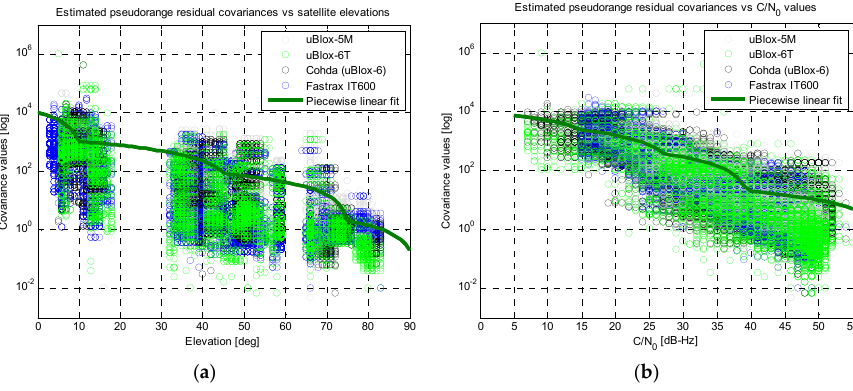
Figure 9. Results of the linear fitting for the covariance of the residuals (logarithmic scale on vertical axes): ( a ) versus satellite elevations; ( b ) versus C/N 0 measurements.